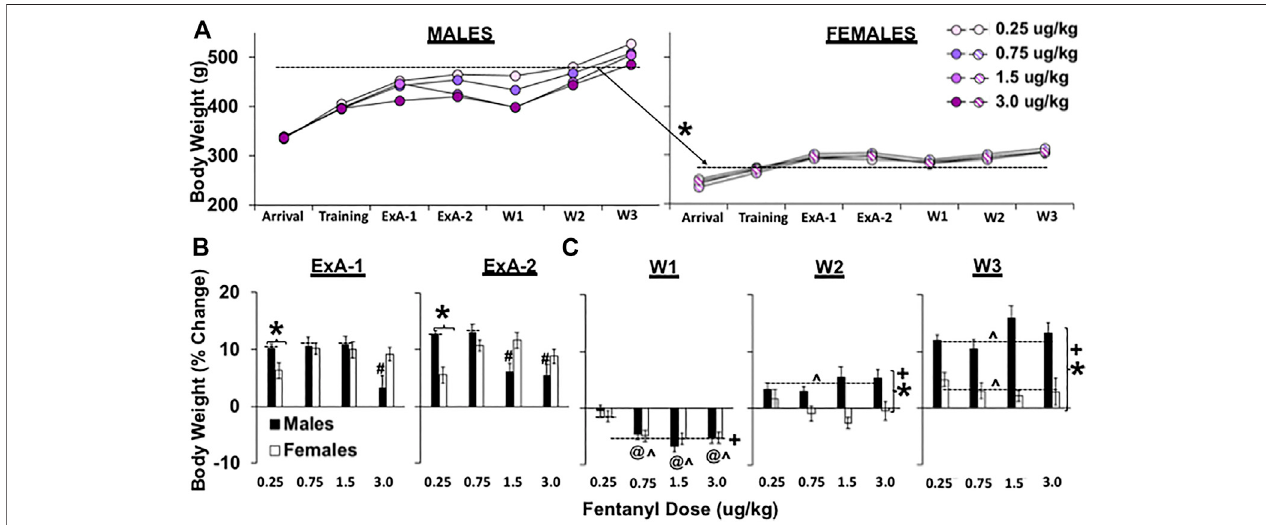
FIGURE 3 | Effect of sex and dose on body weight (g) in female and male rats during extended-access self-administration and withdrawal. Mean (±SEM) body weight (g) at arrival, the end of self-administration training (training, days 3 – 5) just prior to extended-access self-administration, following approximately 5 days (ExA-1, days 4 – 6) and 10 days (ExA-2, days 9 – 10 or at the time of discontinuation of drug self-administration on withdrawal day 1) of extended-access self-administration, and during early (W1, days 2 – 4), intermediate (W2, days 6 – 9), and late withdrawal (W3, days 12, 13, and 14) for males and females in the 0.25 ( n = 8 males, n = 9 females),0.75( n =8males, n = 9females),1.5( n = 8males, n = 8females),and3.0( n = 8males, n = 7females)dose( μ g/kg)conditions (A) .Thesedataarealsoplotted as percent change in body weight after approximately 5 (ExA-1) and 10 (ExA-2) days of extended-access self-administration relative to the end of training (training) just priortoextended-accessself-administration (B) andduringearly,intermediate,andlatewithdrawalrelativetotheendofextended-accessself-administration(ExA-2)just priortowithdrawal (C) . (*)Signi fi canteffect ofsex.(#)Signi fi cantdifference from higher dosesinmales. (+)Signi fi cantdifference betweeneach ofthewithdrawal